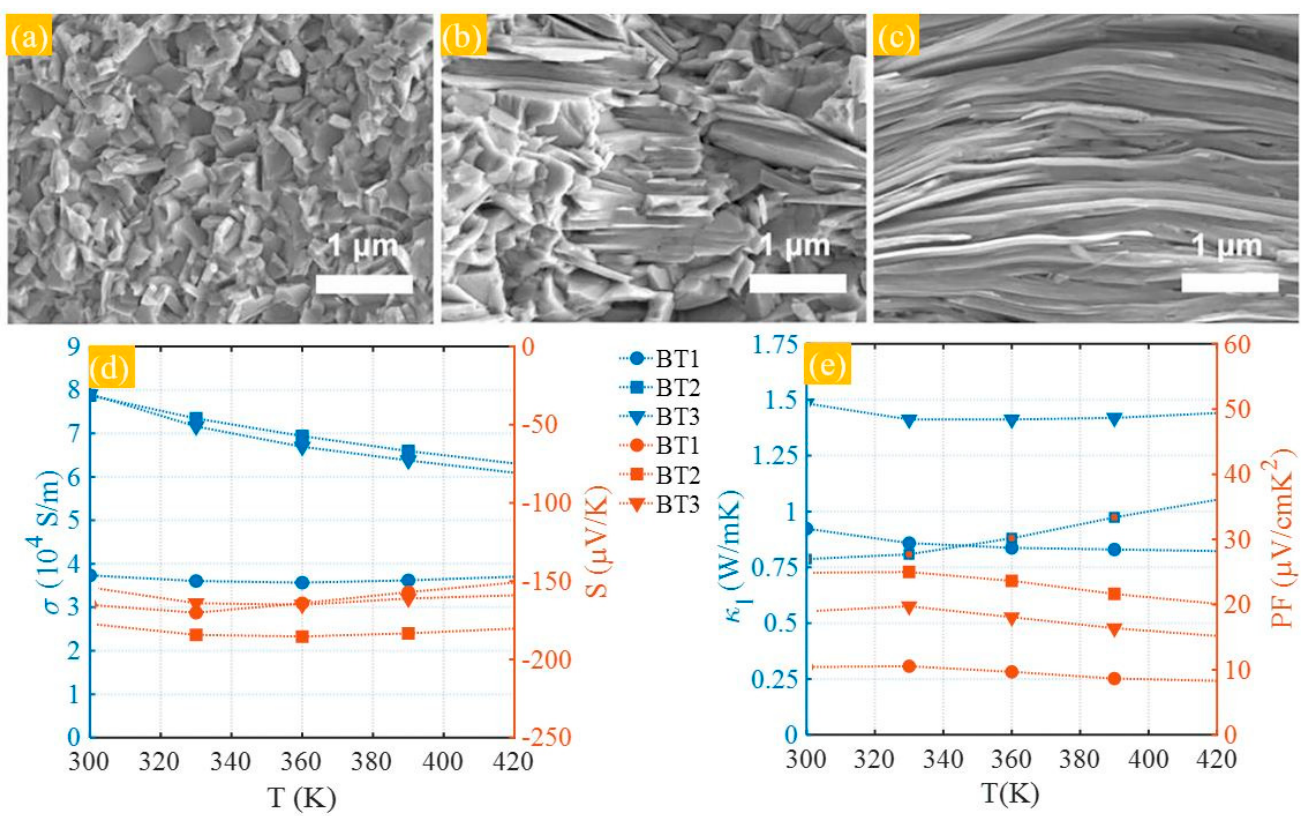
Figure 8. SEM micrographs of the sintered ( a ) Bi 2 Te 3 nanoparticles (BT-1), ( b ) Bi 2 Te 3 thick nanoplates (BT-2), and ( c ) ultrathin Bi 2 Te 3 nanosheets (BT-3). Temperature dependence of ( d ) electrical conductivity, and Seebeck coefficient, ( e ) lattice thermal conductivity, and power factor (adapted from [62] with permission).